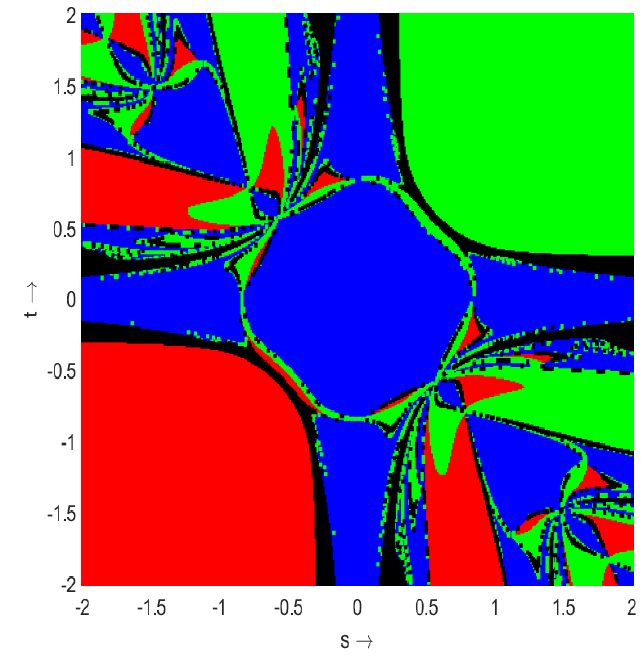
Figure 1. Dynamics of the method (2) with BA for Example